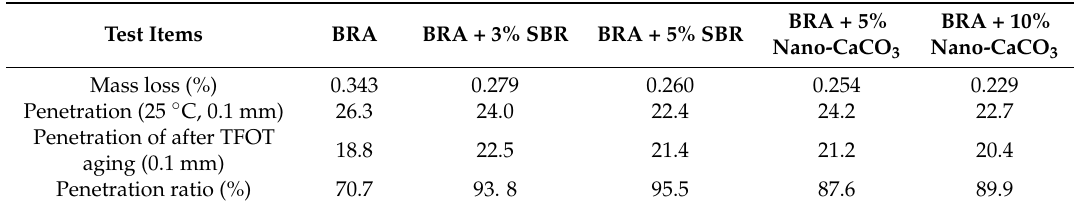
Table 6. The changes of indicators for nano-CaCO 3 /BRA and SBR/BRA compound-modified asphalt after thin film oven test (TFOT) aging.